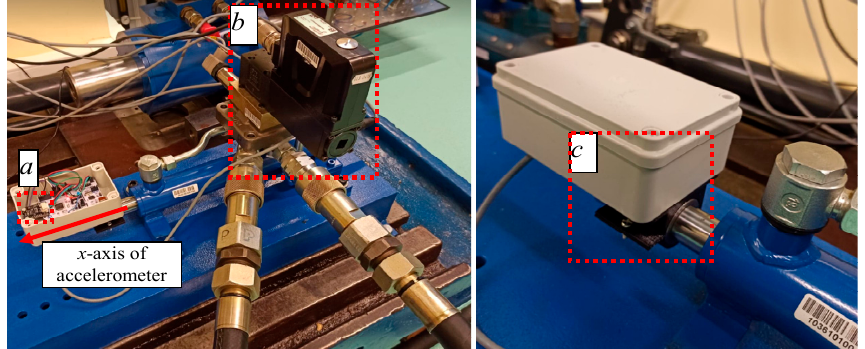
Figure 8. Construction of the test stand: ( a ) microelectromechanical system (MEMS) accelerometer connected with the STM32 microcontroller module, ( b ) VLC electrohydraulic valve and ( c ) sensor module cover with connector.